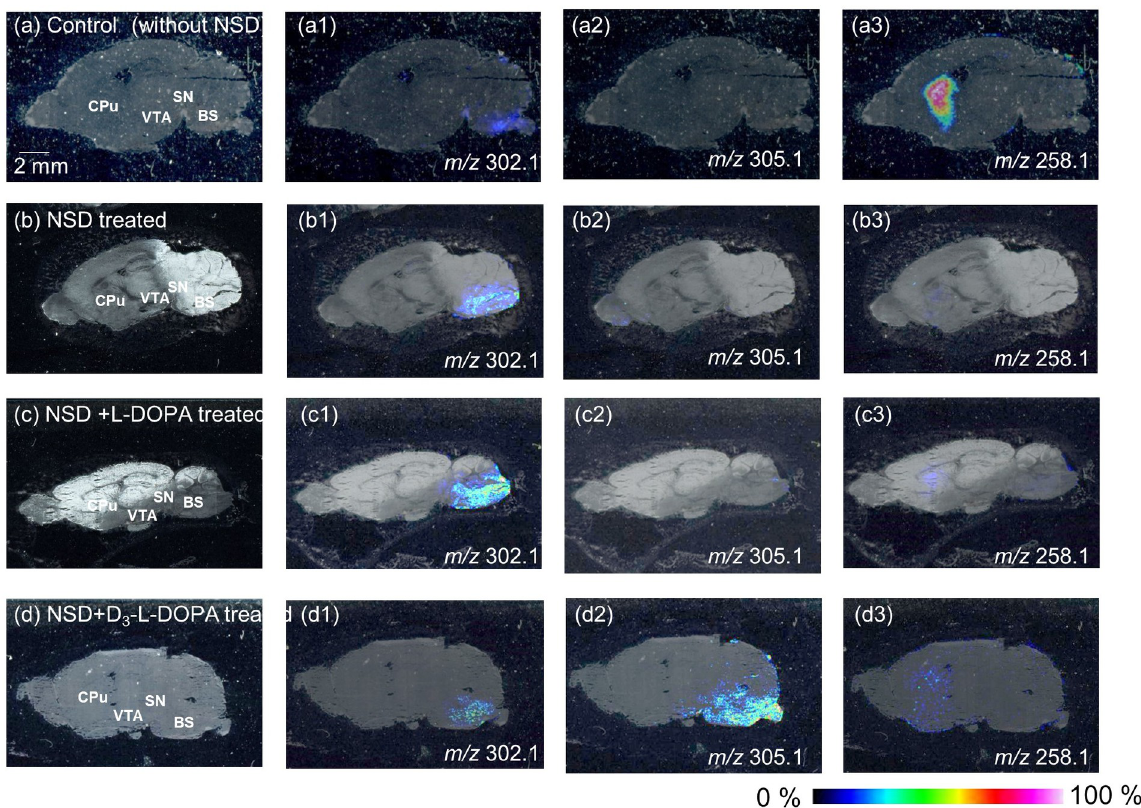
Fig 2. Derivatized imaging mass spectrometry of catechol amines. Optical image of sagittal section from mouse brain saline-treated as control (a), NSD-1015-treated (b), NSD1015 and L-DOPA-treated (c) and NSD1015 and D 3 -L-DOPA-treated (d) mouse. MS spectra reconstructed image of L-DOPA (a1, b1, c1 and d1), D 3 -L-DOPA (a2, b2, c2 and d2) and DA (a3, b3, c3 and d3), BS, brain stem. MY, medulla; OB, olfactory bulb; P, Pons.